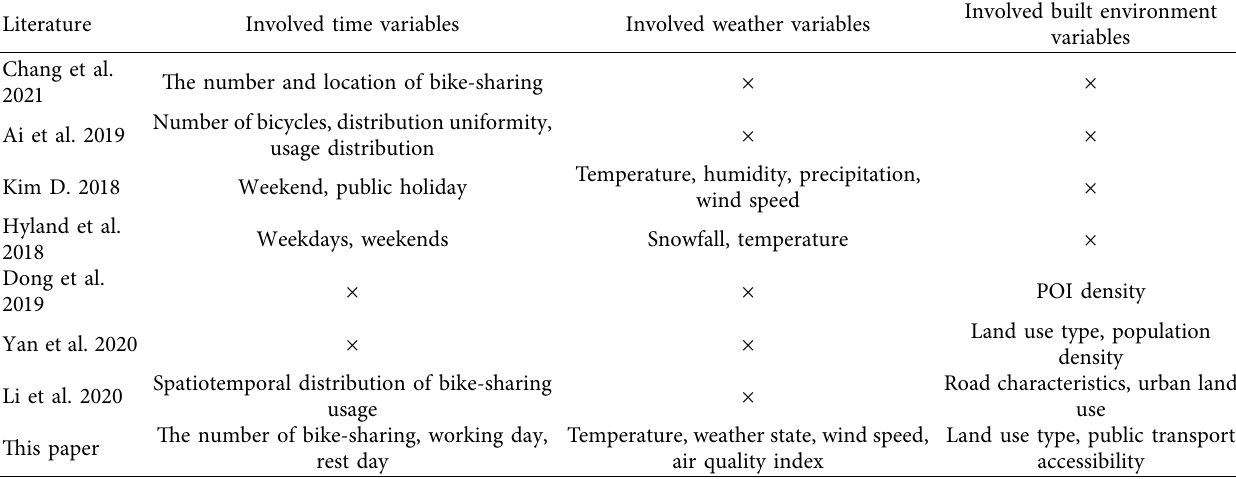
Table 1: Variables involved in the literature about dockless